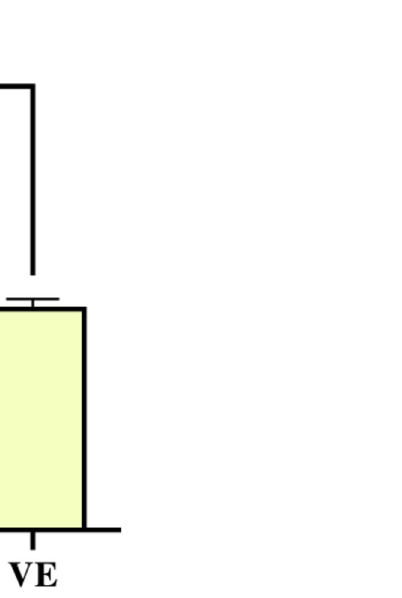
Fig 1. Blood serum VE concentration before and after VE injection after transportation in